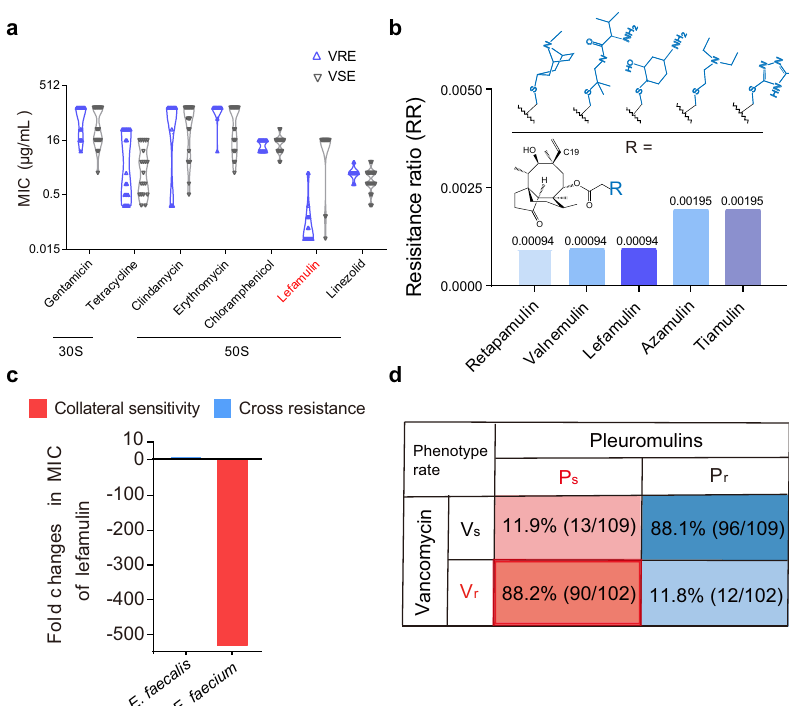
Fig. 2 Collateral response to pleuromutilins is universal in VRE fm . a MIC 50 of eight ribosome-targeting antibiotics against E. faeciums ( n = 40). b Resistance ratios of pleuromutilins against 210 E. faecium isolates. Structures of fi ve pleuromutilins, where the C19 of the tricyclic mutilin core is single bond in azamulin. ( c ) Fold changes in MIC 50 of lefamulin against E. faecium s ( n = 210) and E. faecalis ( n = 10). d Proportion of four phenotypes in E. faeciums . ~90% VRE n = 102) are sensitive to pleuromutilins, whereas ~90% of VSE n = 109) are resistant. Vs: sensitivity to vancomycin, Vr: fm ( fm ( resistance to vancomycin, Ps: sensitivity to pleuromutilins, Pr: resistance to